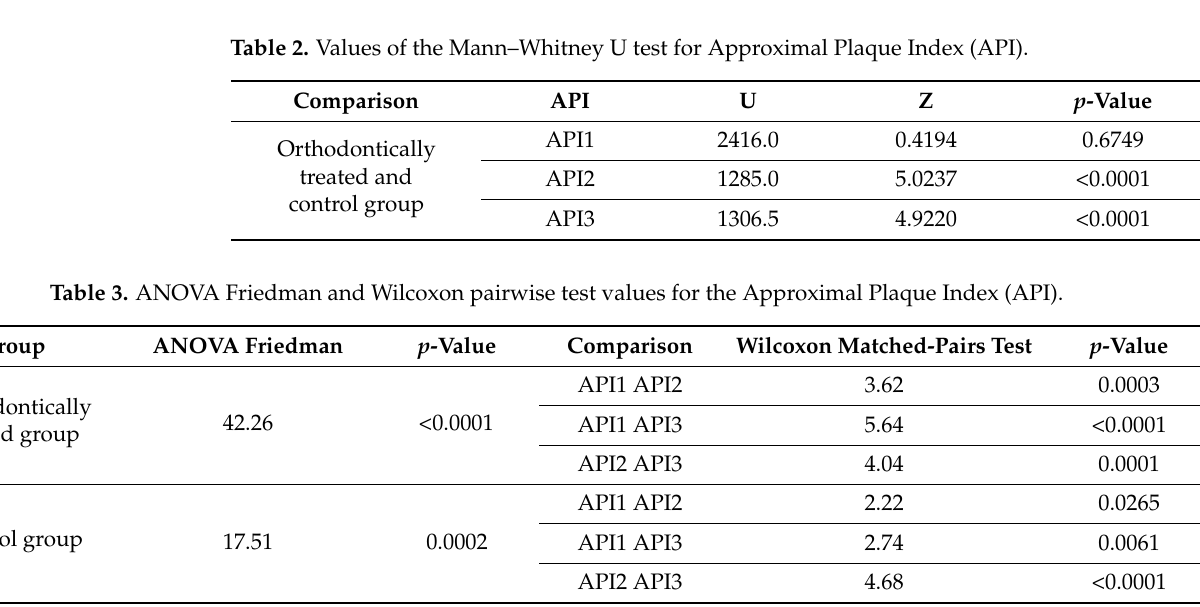
Table 2. Values of the Mann–Whitney U test for Approximal Plaque Index (API).